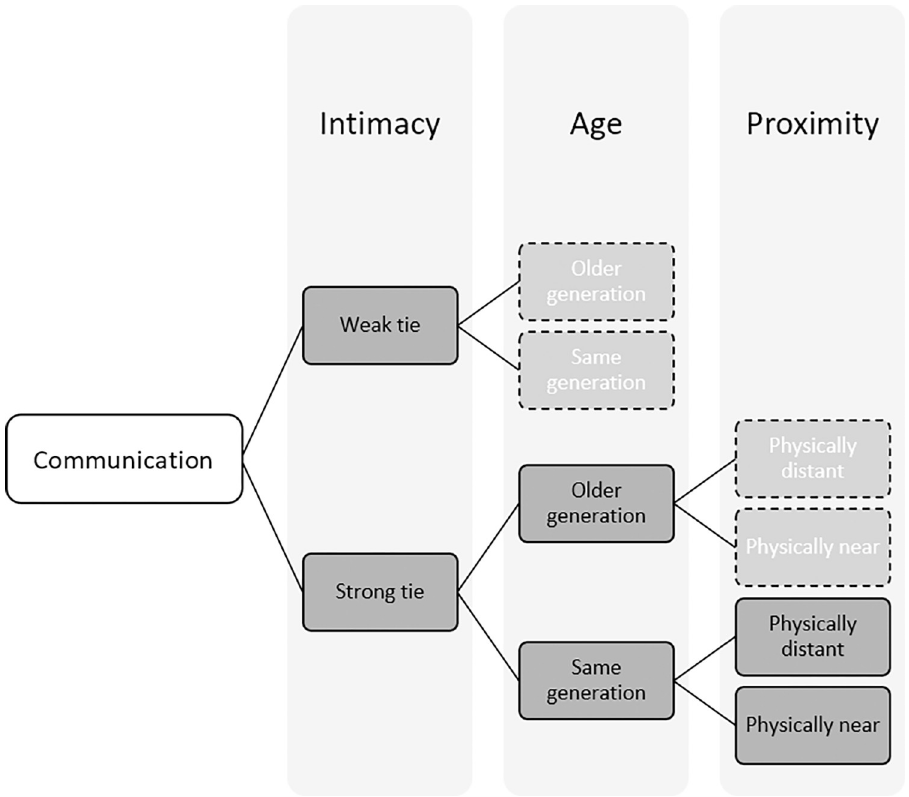
Fig 3. The predictive importance of intimacy, age, and proximity. The influence of a relationship feature on the structure of a communication decreases the further to the right and the more transparent that feature appears in the above diagram. Thus, opaque features are more important and transparent features less so; and intimacy is more important than age, which is more important than